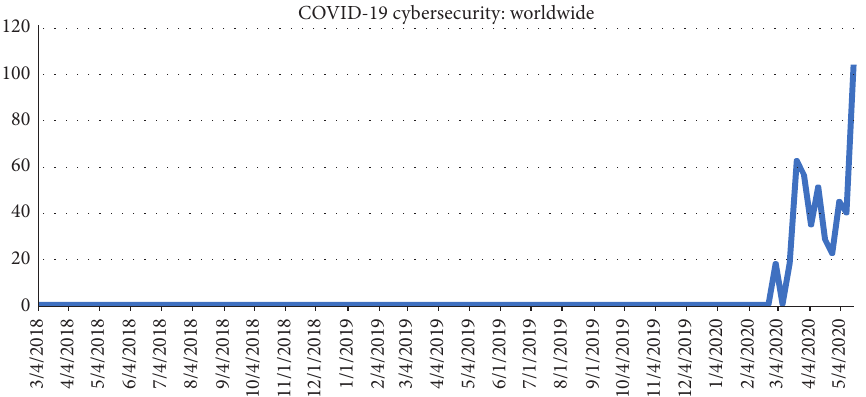
Figure 4: COVID-19 cybersecurity-based Google